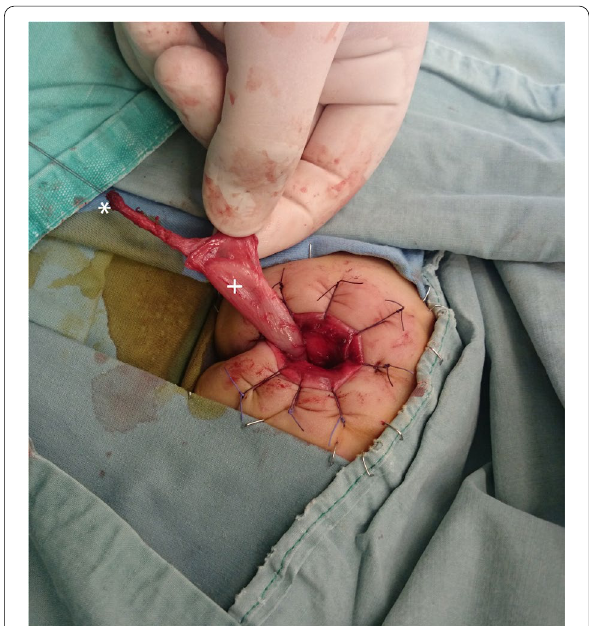
Fig. 2 At the end of the dissection. The distal rectal pouch (*), the proximal rectal pouch (